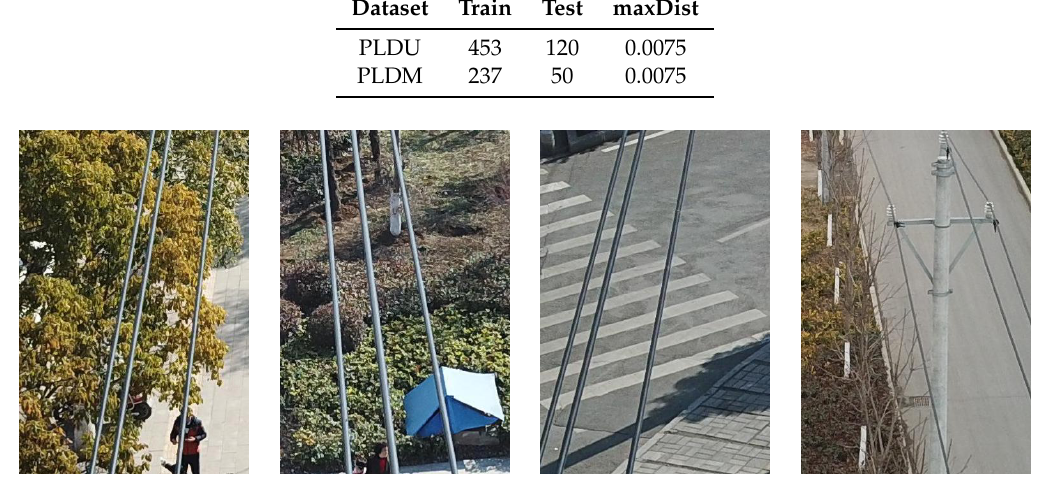
Figure 4. Example images of power lines in PLDU